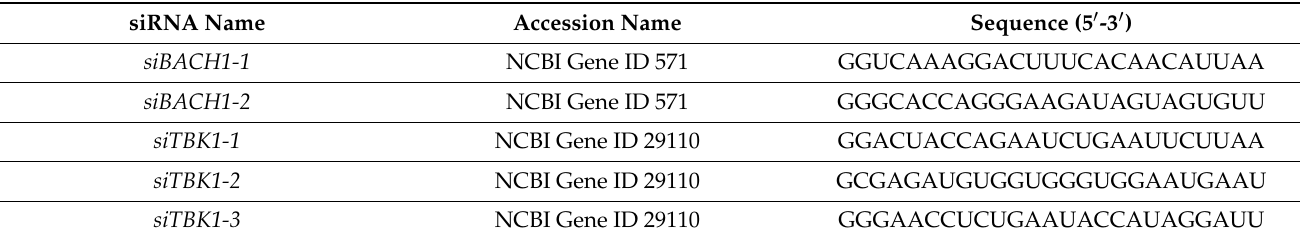
Table 1. Table 1. Sequences of